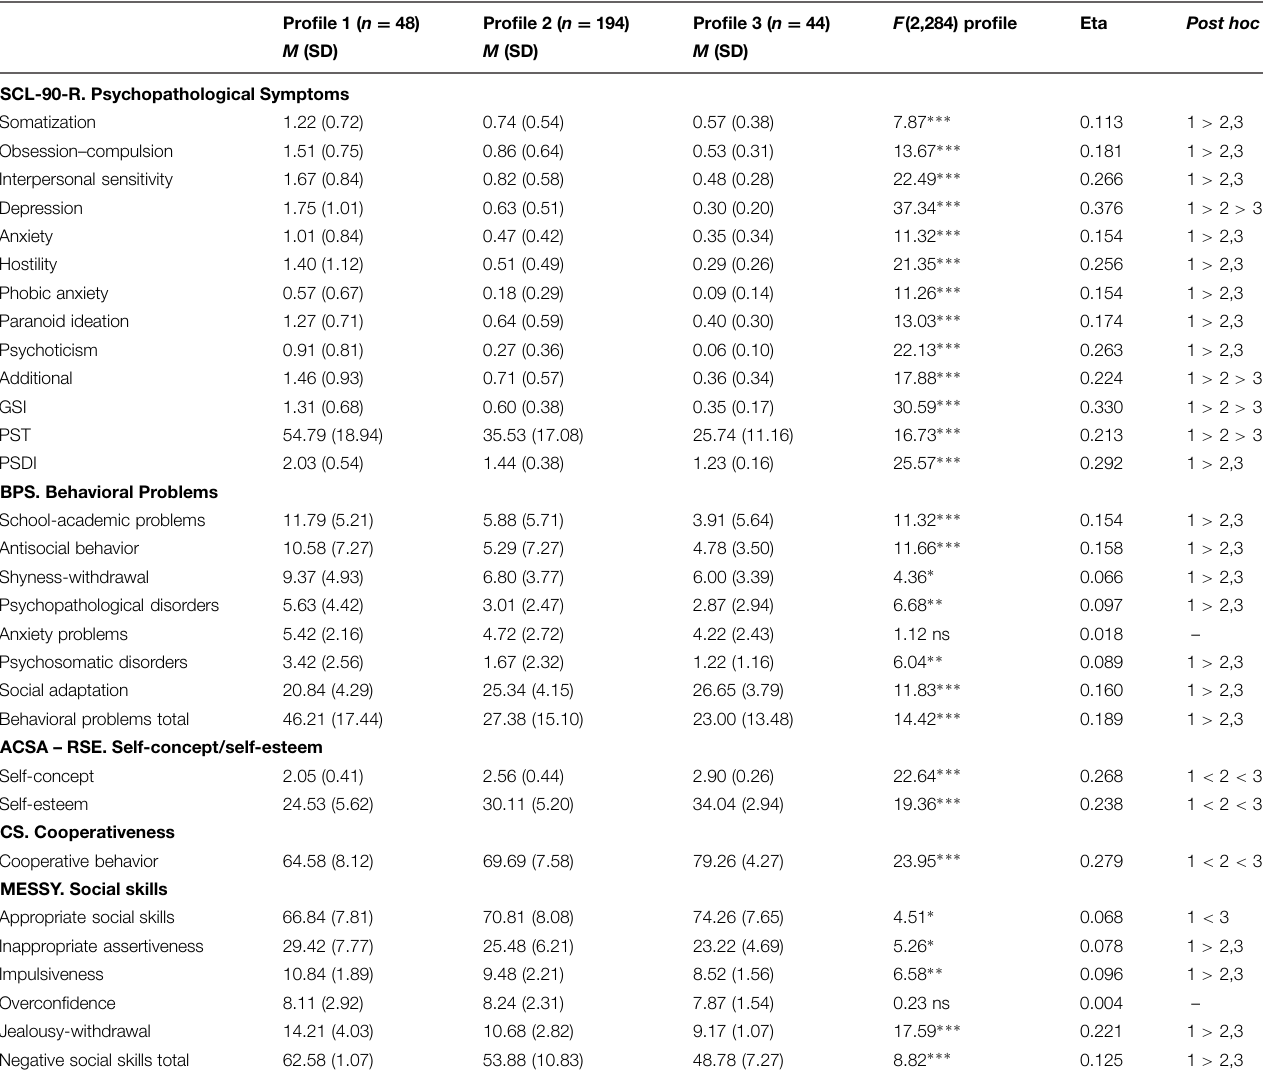
TABLE 3 | Means and SD of all the variables in the three happiness profiles (low, medium, high), and results of the analysis of variance as a function of profile, effect size (Eta), and post hoc tests